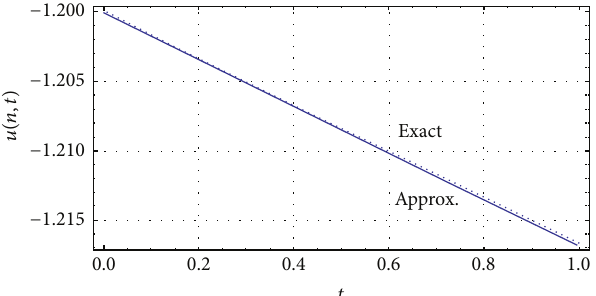
Figure 4: The behavior of the approximate solution using HPTM via optimal parameter when 𝜇 = 0